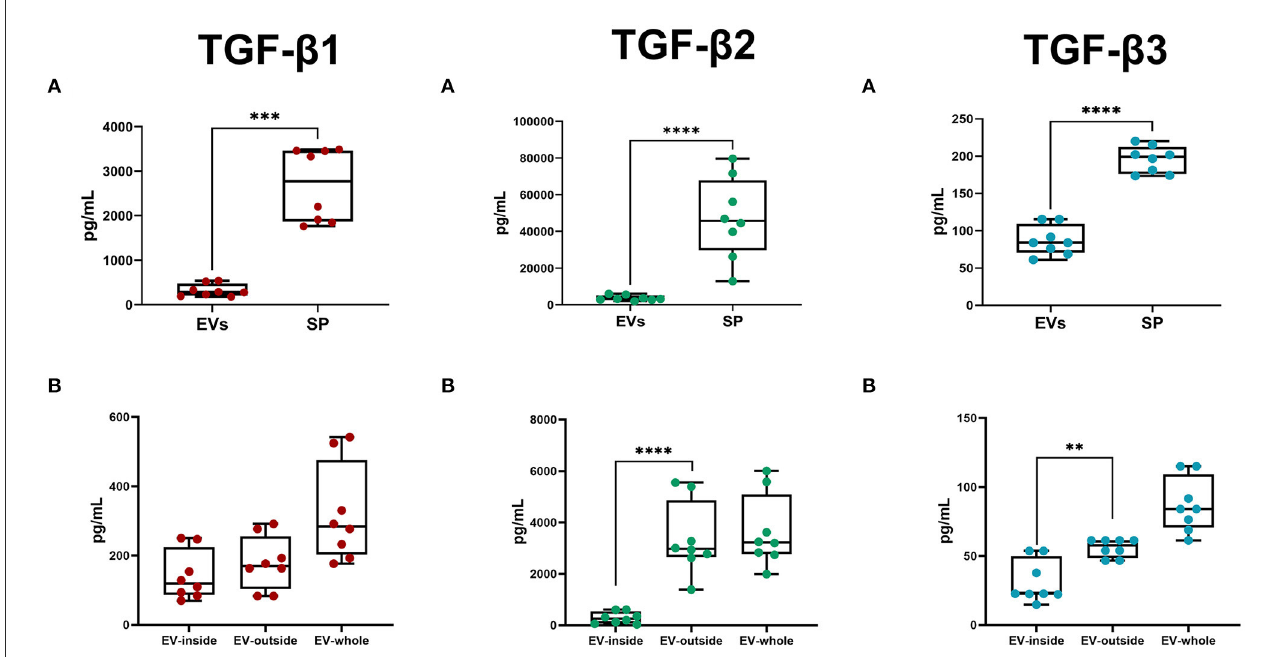
FIGURE8 Box-whisker plots showing the concentrations (pg/mL; mean ± SEM) of Transforming Growth Factor (TGF) - β 1, - β 2, and - β 3 in pig. (A) Seminal plasma (SP) and seminal extracellular vesicles (EVs; lysed). (B) EV-inside (Difference between lysed and non-lysed EVs), EV-outside (non-lysed EVs), and EV-whole (lysed EVs). Data of eight SP pools. Boxes enclose the 25th and 75th percentiles, whiskers extend to the 5th and 95th percentiles and the line indicates the median, and dots represent the seminal TGF- β s values. **** P < 0.00001; *** P < 0.0001; ** P < 0.001.